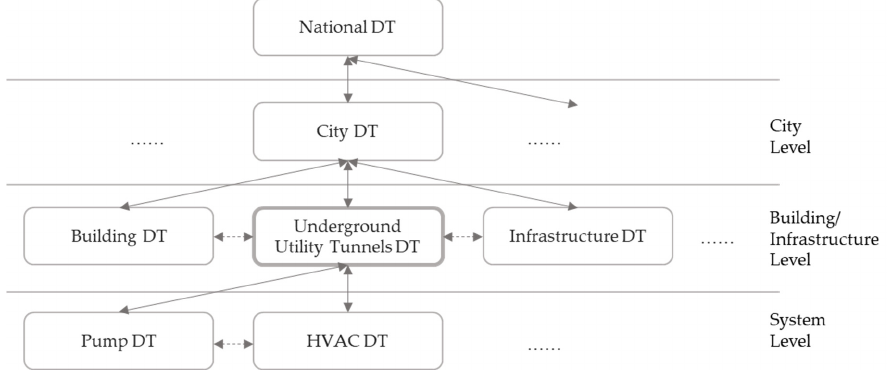
Figure A1. Connections, hierarchy, and level of digital twins [19].